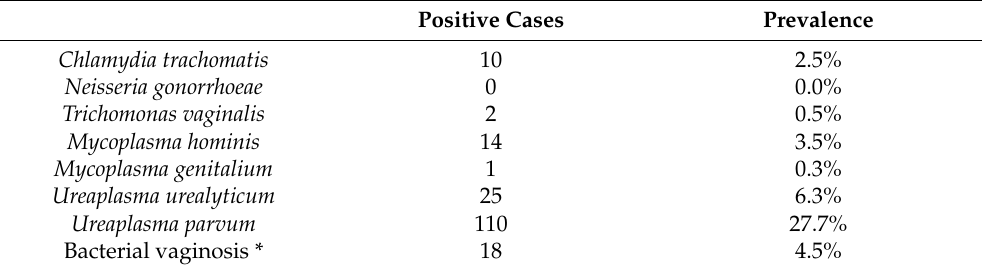
Table 2. Number of positive cases and prevalence of C. trachomatis , N. gonorrhoeae , T. vaginalis